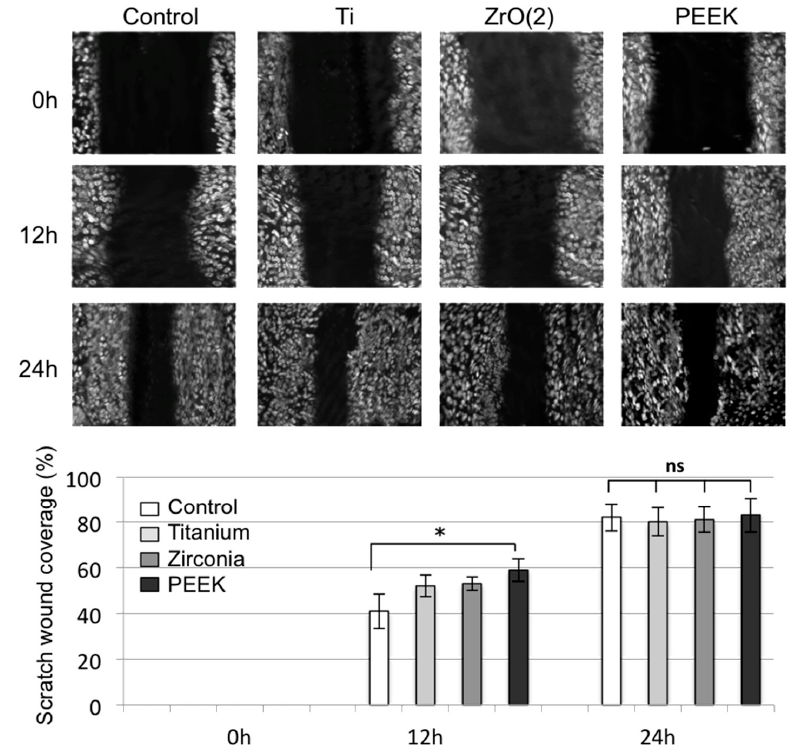
Figure 4. Cell migration (scratch wound healing assay). HEGK cell nuclei were labeled with fluorescent dye Hoechts 33342 and images were recorded 24 h after wounding. Representative images are shown from three independent experiments and dark define the areas lacking cells (wound area, ImageJ). Values of percentage wound closure ± SEM (n = 3): *p < 0.01.